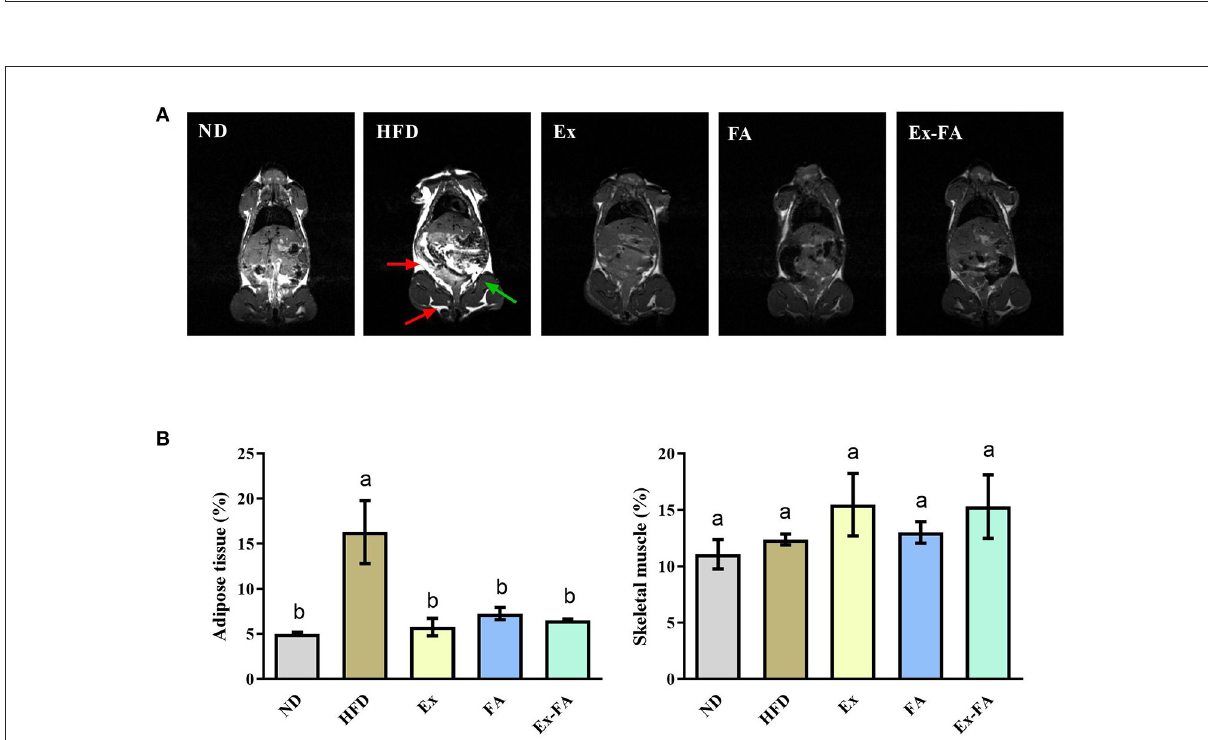
FIGURE2 Effects of Ex, FA, and Ex-FA on body composition in HFD-fed mice. (A) Magnetic resonance images; (B) Proportions of adipose tissue and skeletal muscle. The proportions of adipose tissue and skeletal muscle were calculated from the magnetic resonance images. The red arrow represents adipose tissues, and the green arrow represents the hindlimb skeletal muscle. ND, normal diet group (control); HFD, high-fat diet group (model); Ex, high-fat diet with exercise; FA, high-fat diet with ferulic acid; Ex-FA, high-fat diet with exercise and ferulic acid. Data are expressed as mean ± SD ( n = 3). Means with different letters are significantly different ( P <